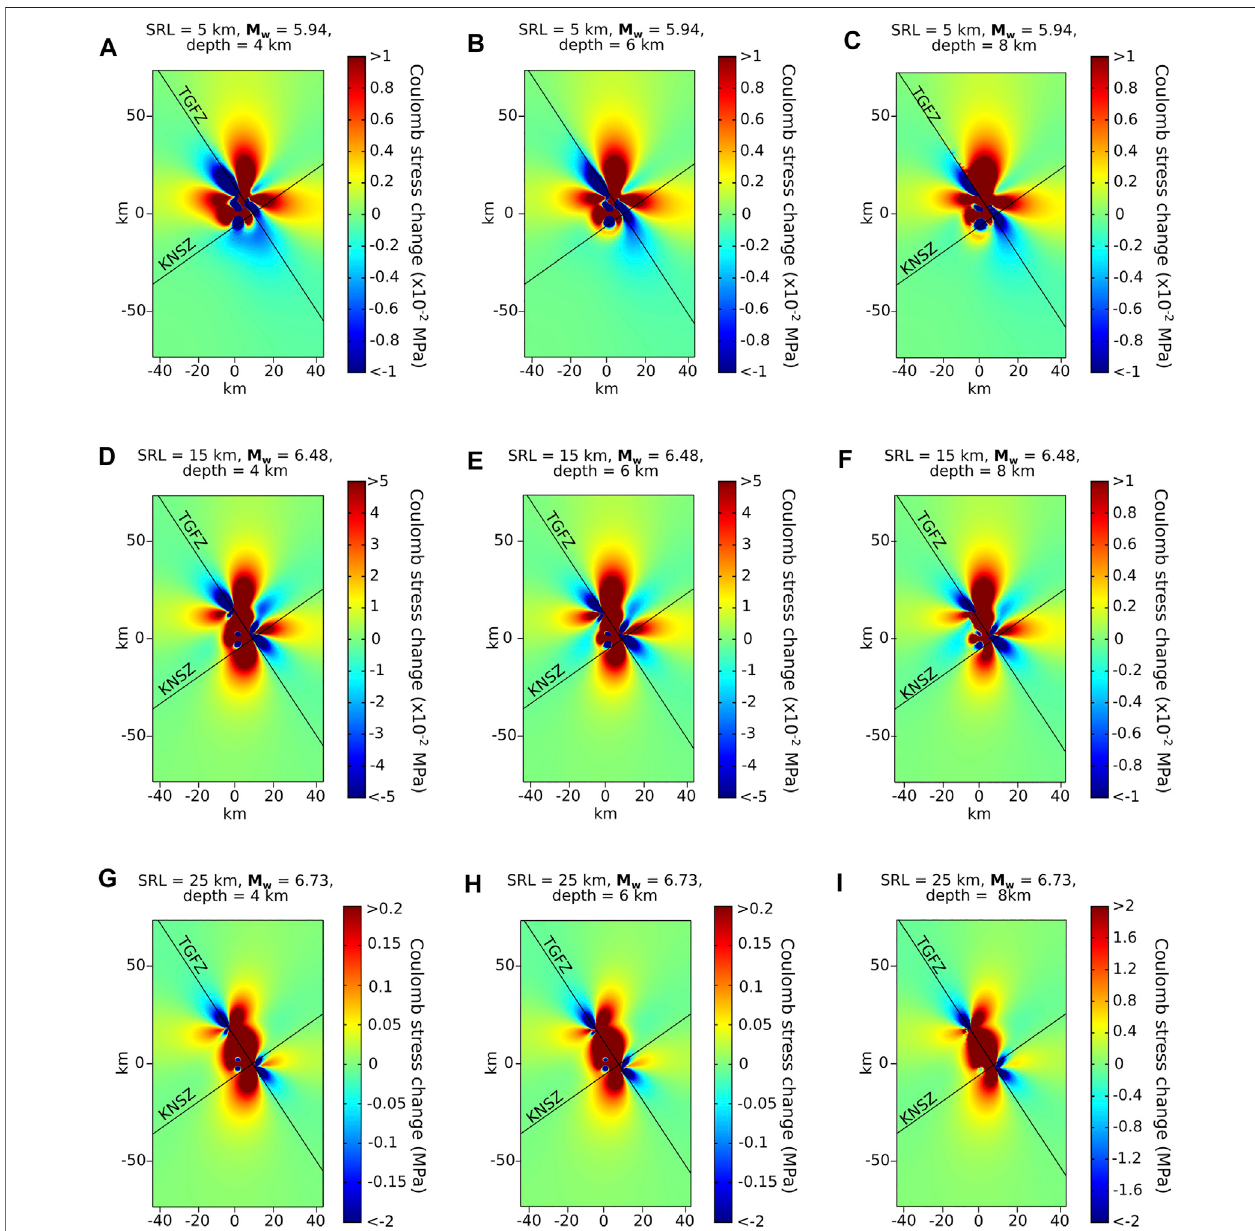
FIGURE7| ModeledCoulombfailurestresschangesatselecteddepthsonverticalplanesparalleltotheKaraman-Ni ğ deshearzone(trending55 ° NE)asaresultof hypothetical earthquakes along the AKFS with a rake of − 175 ° commensurate with the gradual slip distribution of 0.58 mm yr − 1 right-lateral slip, and 0.0536 mm yr − 1 normal slip. (A – C) Coulomb failure stress change due to aM w (cid:1) 5.94 earthquake with surface rupture length (SRL) of5 km. (D – F) for M w (cid:1) 6.48 and SRL (cid:1) 15 km. (G – I) for M w (cid:1) 6.73 and SRL (cid:1) 25 km. Note the change in scales as magnitude and depth increase.